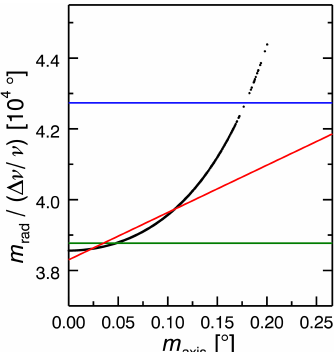
Figure 3. Linear approximation of differential rotation. A solar line shift measurement constrains the mispointing to lie on a line with constant velocity component along the observer’s line of sight (blue line). Linear approximation of this relation results in a constraint of mispointing on rays r tilted away from the solar rotation axis by an angle (cid:49)α and with a minimum distance m 0 to the axis (red